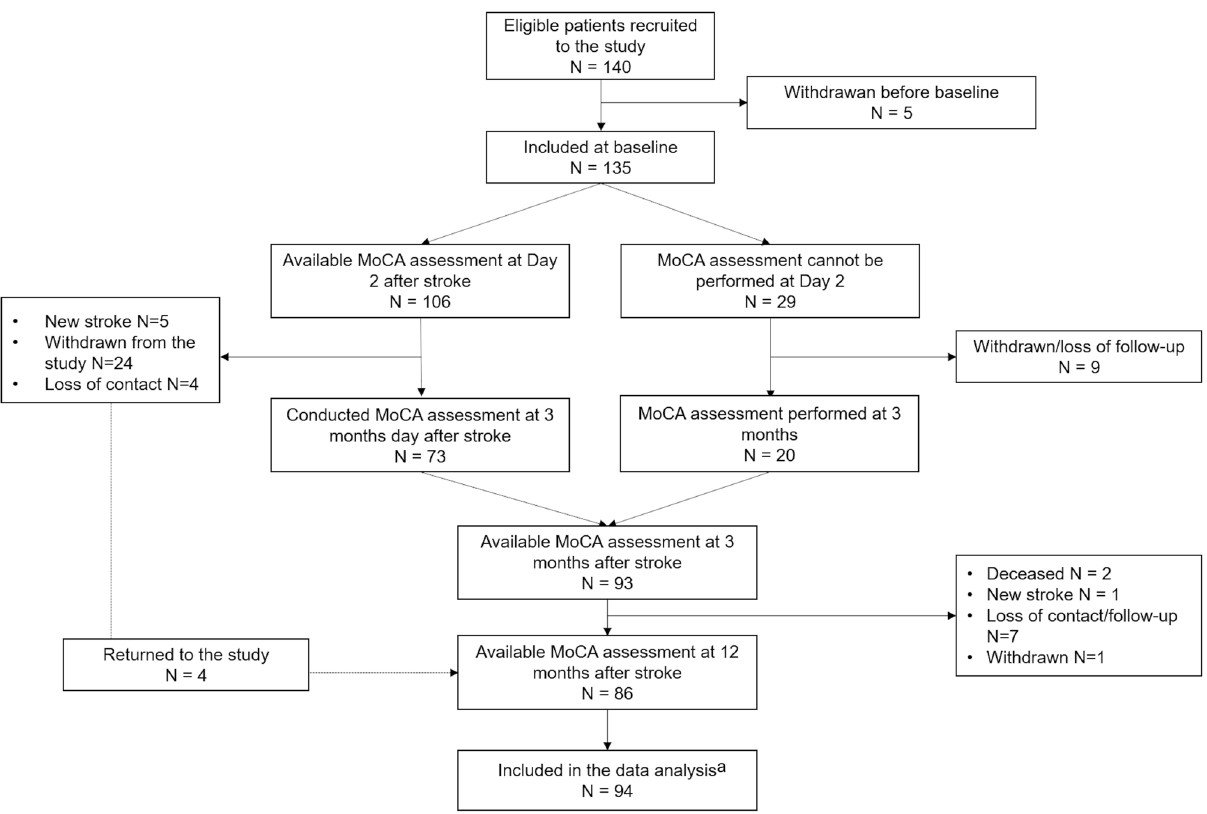
Figure 1. Flow chart summarizing study sample recruitment and inclusion and exclusion for longitudinal data analysis. a 94 patients who had two or more longitudinal assessments of MoCA were included into the